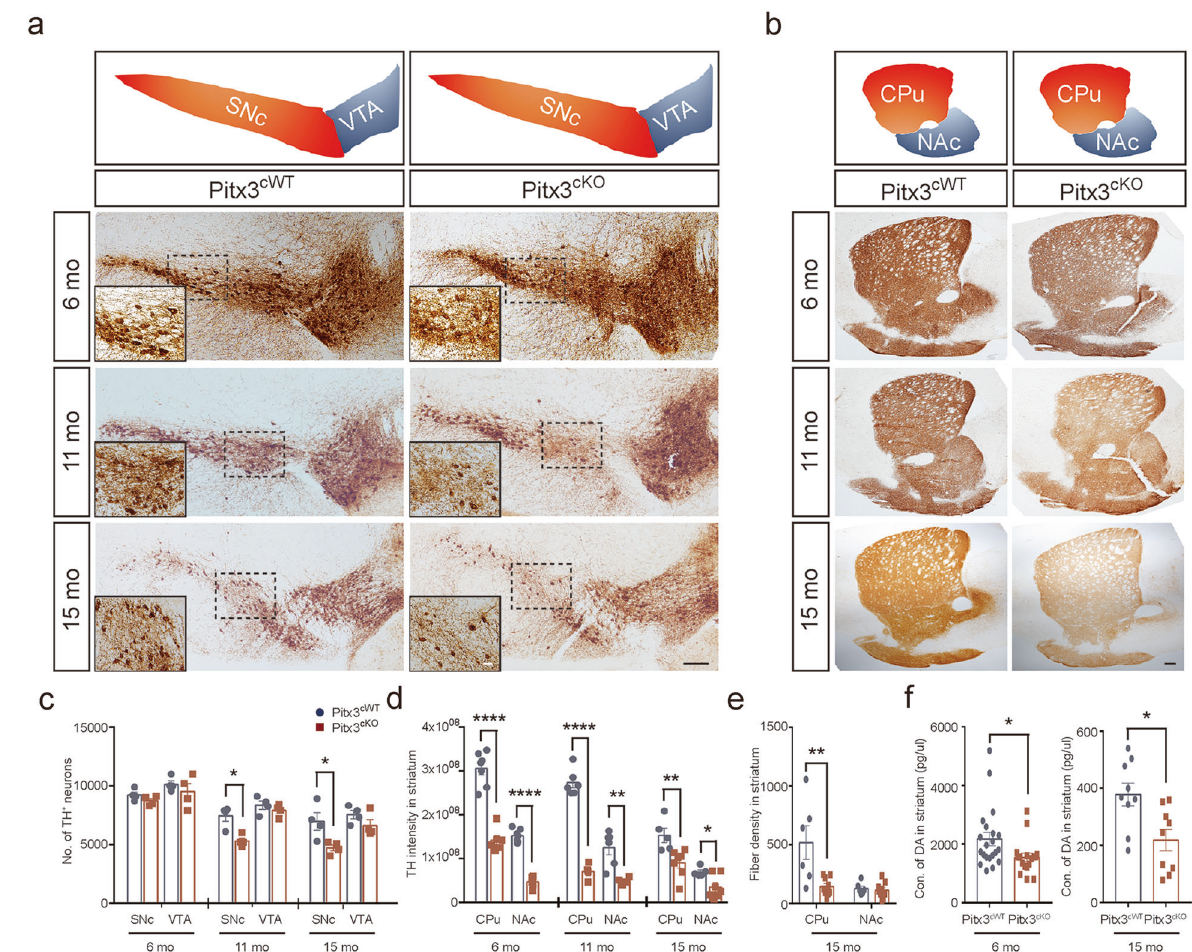
Fig. 2 Neuropathological examination of the SNc-striatal pathway of Pitx3 cKO mice. a IHC staining of TH in the ventral midbrain sections from 6-, 11-, and 15-month-old Pitx3 cWT and Pitx3 cKO mice. SNc and VTA are highlighted with red and blue colors, respectively (scale bar: 100 μ m; high-magni fi cation, 50 μ m). b IHC staining of TH in the striatal sections from 6-, 11-, and 15-month-old Pitx3 cWT and Pitx3 cKO mice. CPu and NAc are highlighted with red and blue colors, respectively (scale bar, 100 μ m). c Quanti fi cation of TH + neurons in the SNc and VTA from 6-, 11-, and 15-months-old Pitx3 cWT and Pitx3 cKO mice ( N = 3-4 mice per genotype). Mann – Whitney test, * p = 0.0286 (11 months old for SNc); unpaired t -test, * p = 0.0299 (15 months old for SNc). d Quanti fi cation of TH IHC intensity in the striatum from 6-, 11-, and 15-months-old Pitx3 cWT and Pitx3 cKO mice ( N = 4 – 7 mice per genotype). Unpaired t -test, **** p < 0.0001 (6 months old for CPu and NAc); **** p < 0.0001 (11 months for CPu); ** p = 0.0053 (11 months for NAc); ** p = 0.0095 (15 months for CPu); and * p = 0.0233 (15 months for NAc). e Quanti fi cation of TH + fi ber density in the striatum from 15-month-old Pitx3 cWT and Pitx3 cKO mice ( N = 6 – 9 mice per genotype). Unpaired t -test, ** p = 0.0078 (CPu). f Striatal DA levels in 6- and 15-month-old Pitx3 cWT and Pitx3 cKO mice ( N = 9 – 21 mice per genotype). Mann – Whitney test, * p = 0.0148 (6 months old); and * p = 0.0102 (15 months